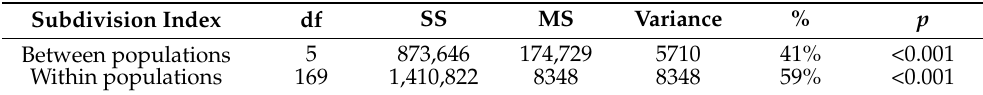
Table 5. Assessment of genetic intra- and interpopulation variability in P. sylvestris populations by